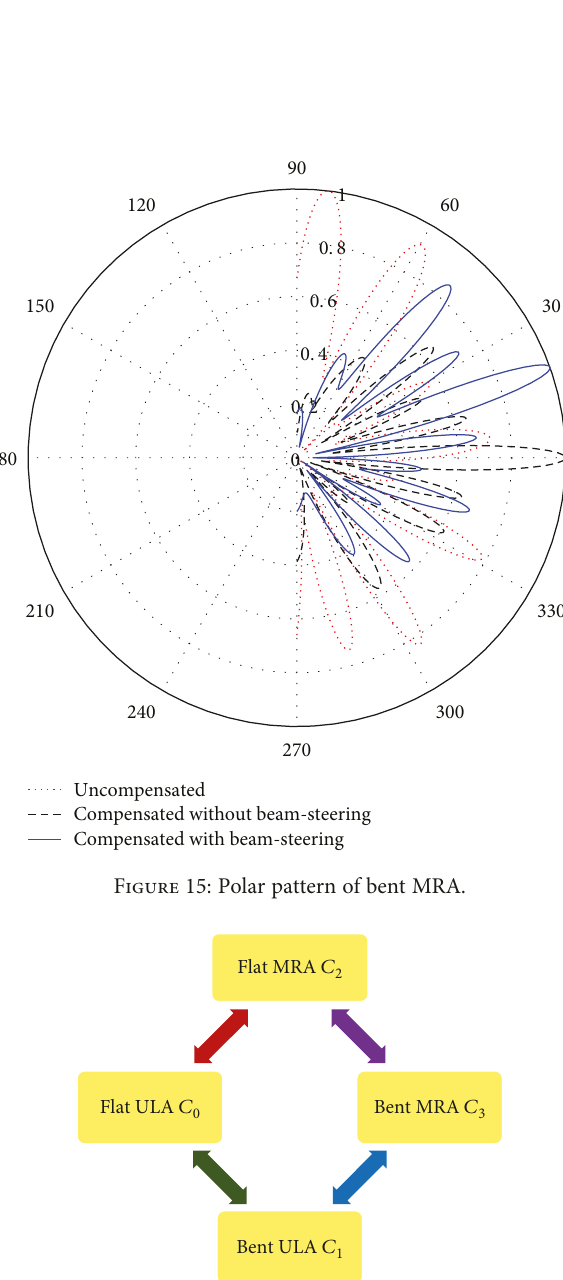
Figure 16: Possible array states and transitions between